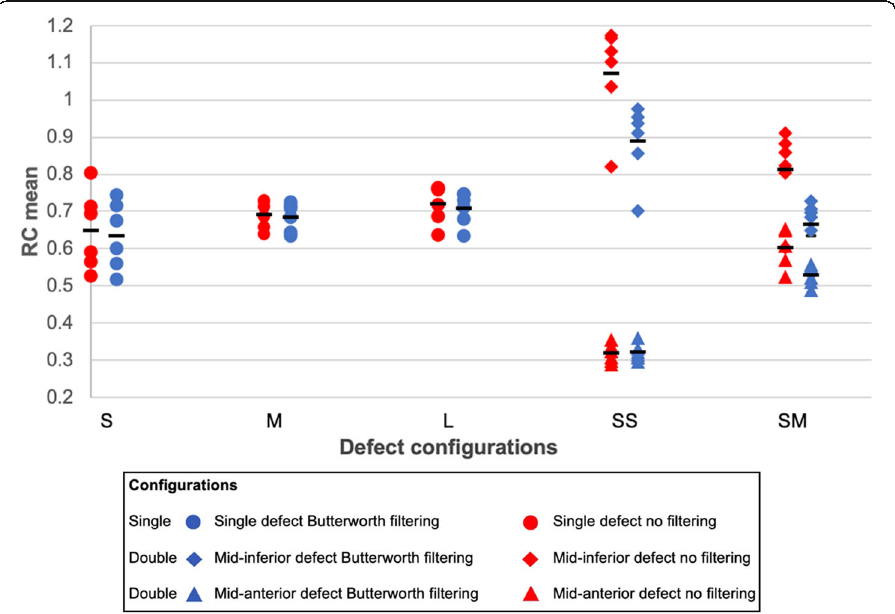
Fig. 3 Recovery coefficients (RC) of single and two defects: small (S), 2.6 mL; medium (M), 5.6 mL; and large (L), 11.8 mL. The defect RC of Evolution with (blue) and without Butterworth post-filtering (red).